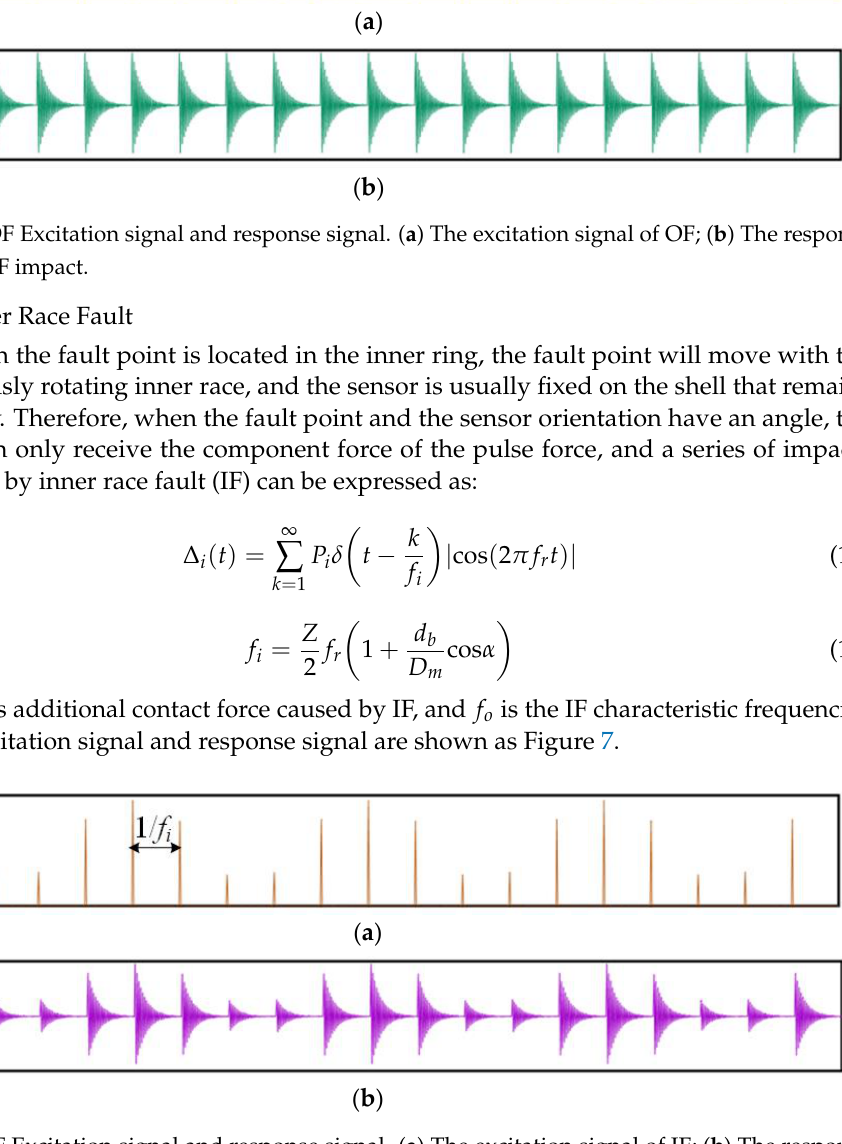
Figure 7. IF Excitation signal and response signal. ( a ) The excitation signal of IF; ( b ) The response signal of IF